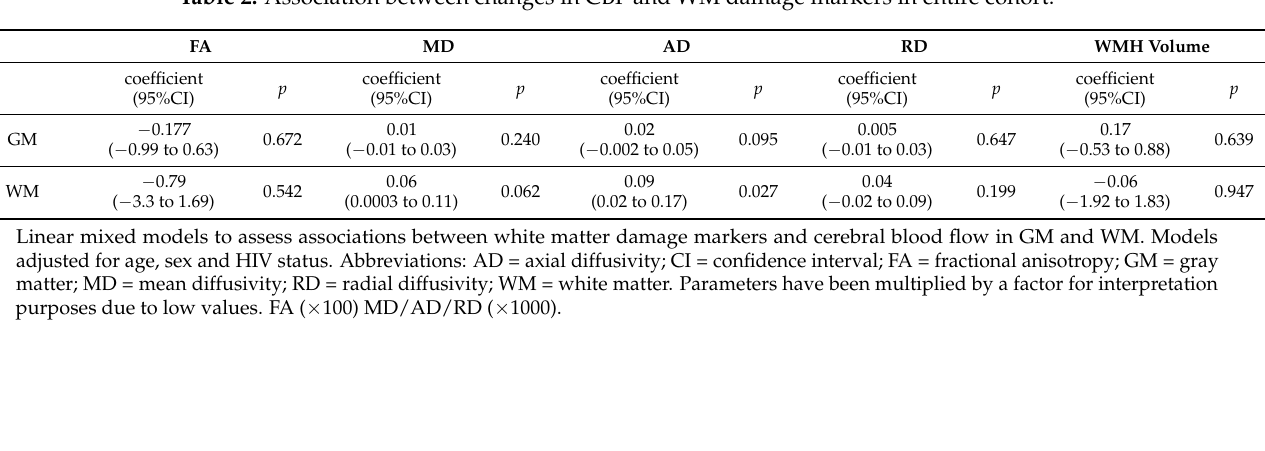
Table 2. Association between changes in CBF and WM damage markers in entire